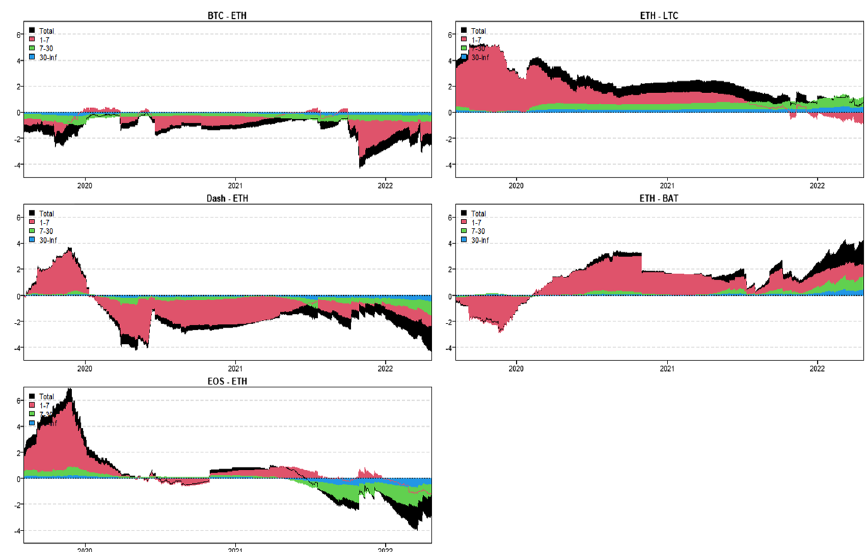
Fig. 18 Dynamic net-pairwise connectedness—realized kurtosis (RK)-ETH